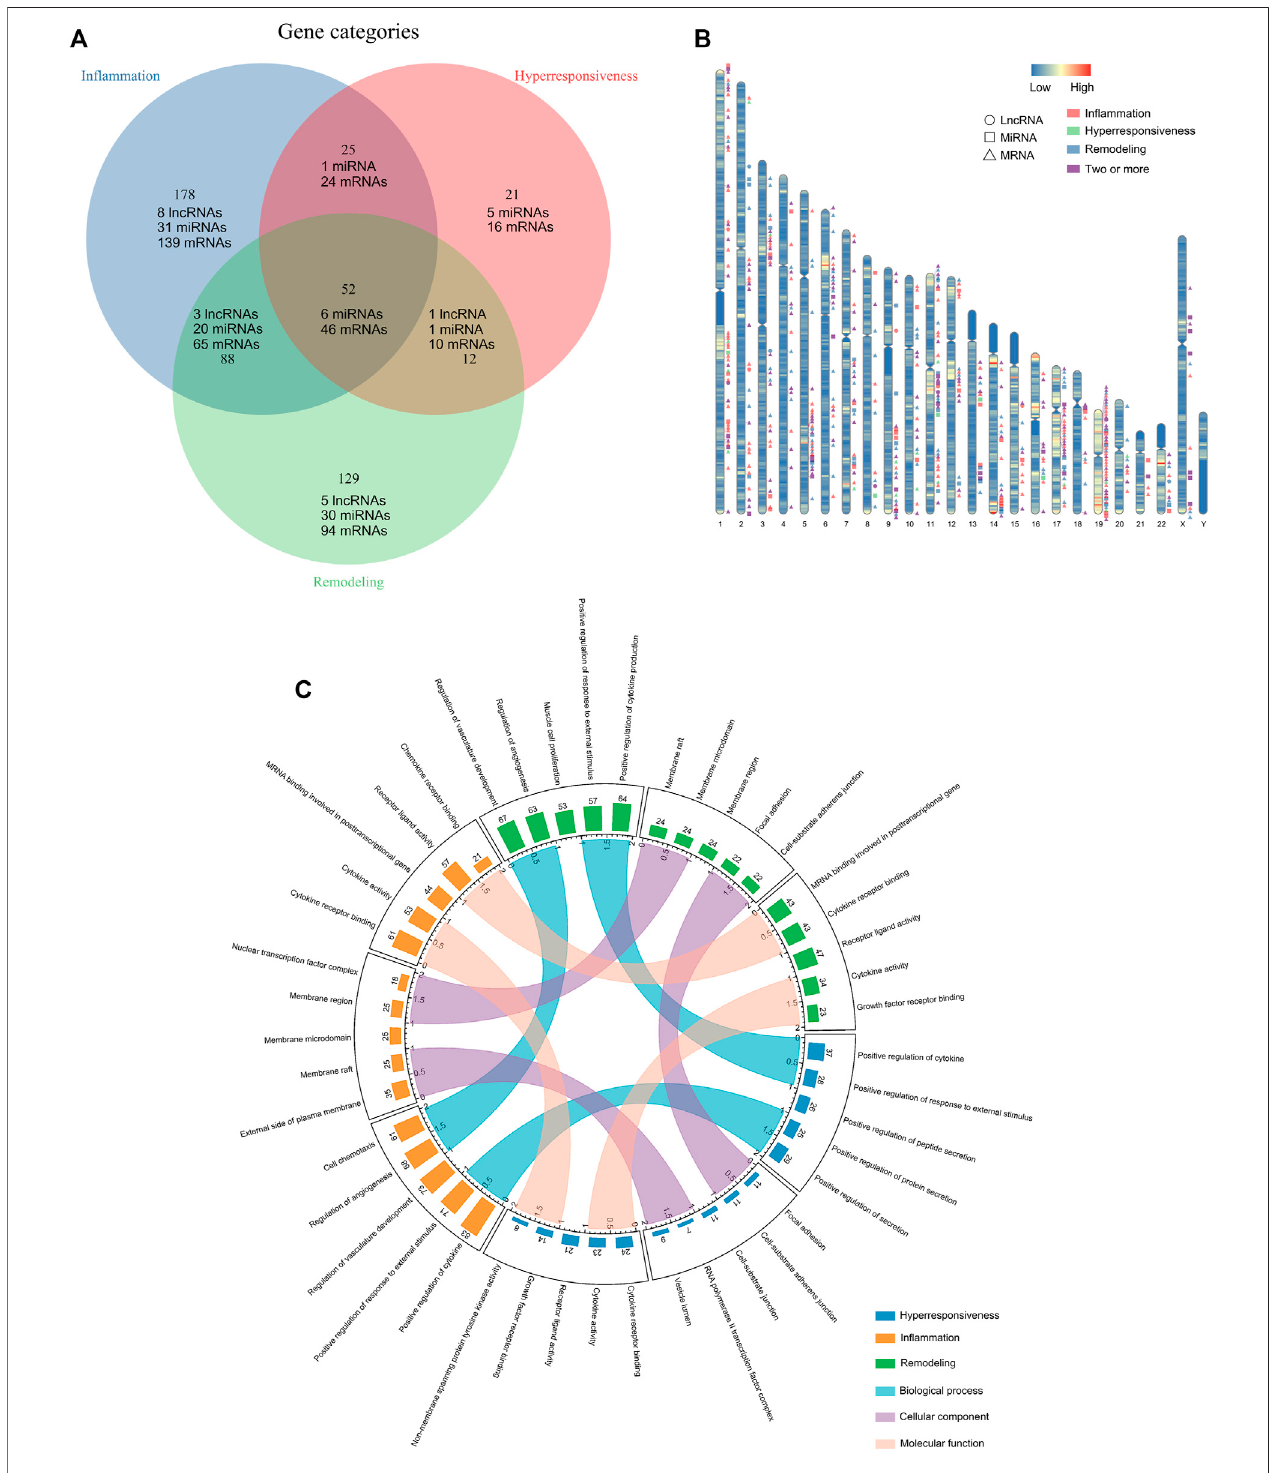
FIGURE 1 | Compiling the disease feature risk transcriptome. (A) The distribution of disease characteristics-associated genes. (B) Spatial distribution of disease characteristics-related genes on chromosomes. (C) The top fi ve statistically signi fi cant Go term annotations of disease characteristics-associated genes and the similarity measuring.